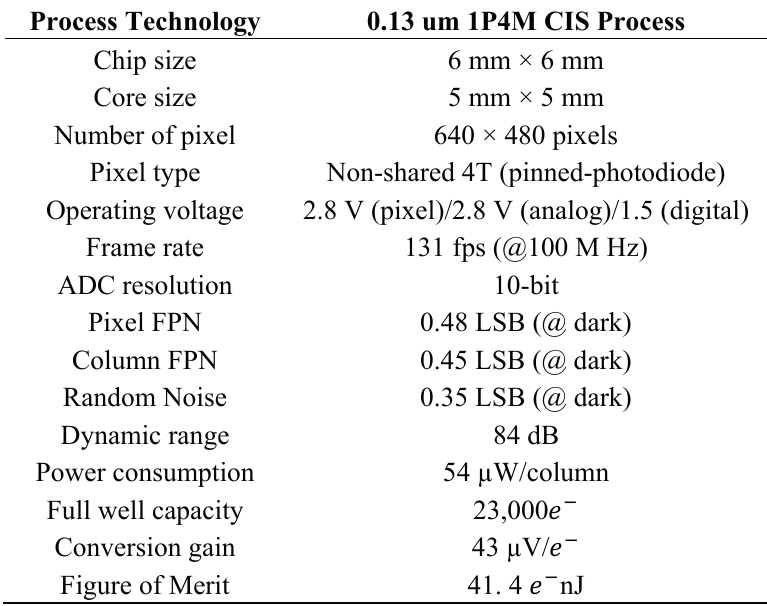
Table 3. Summary of the measured CIS performance.